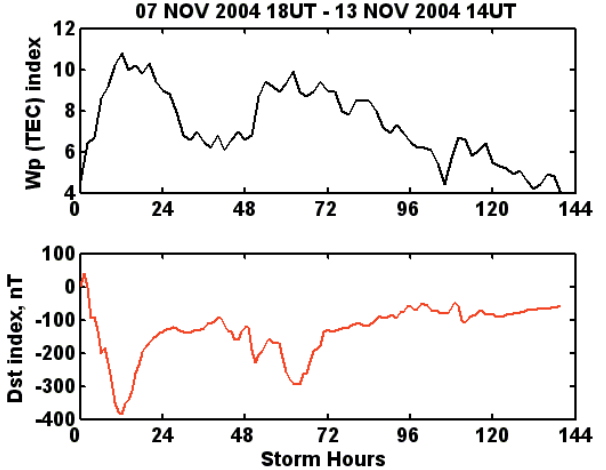
Fig. 2. Coherent ionospheric W p index and magnetospheric D st index during space weather super-storm on 7 to 13 November 2004.